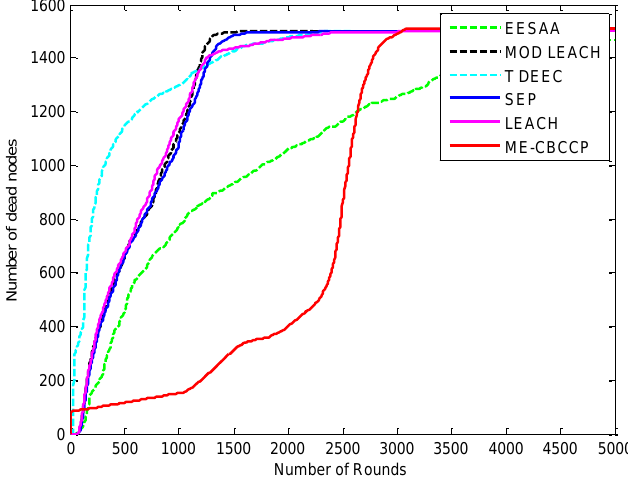
Figure 8. Transmission delay (II) (1000 nodes, 200 m 2 ).